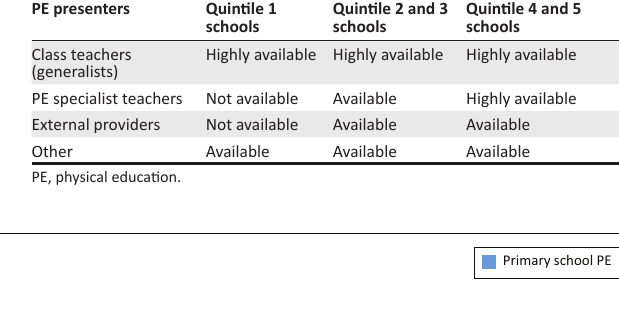
TABLE 2: Presenters who implement physical education per school